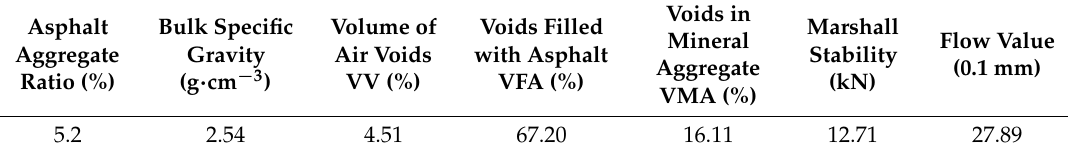
Figure 1. Aggregate gradation. Table 3. Marshall test results at optimal asphalt content.